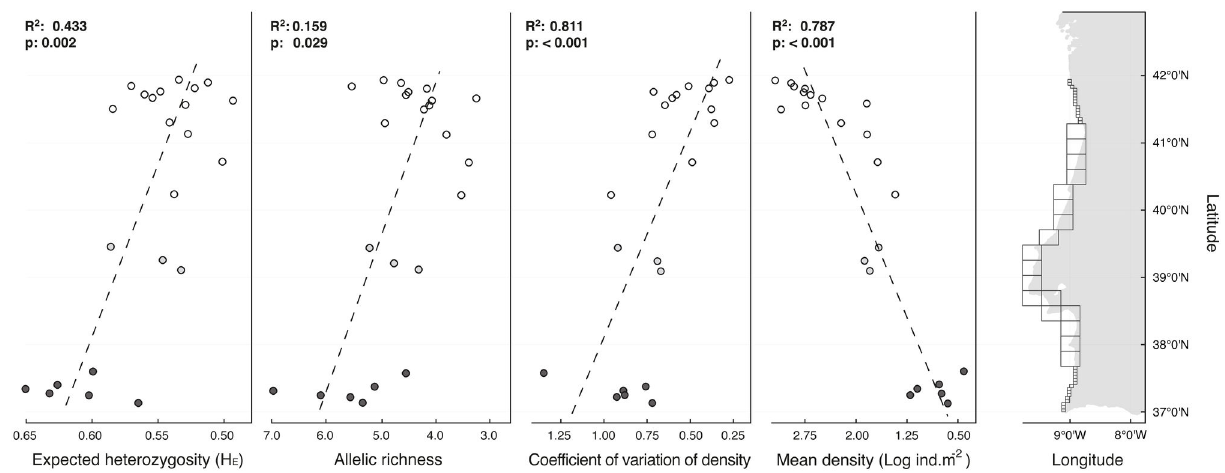
Figure 1. Sampling scheme for S. polyschides (cells represent the sampling units) within 25 km cells along the study range, and for detailed northern-southern comparisons within sub-cells of 5 km. Expected heterozygosity (H coefficient of variation of density and mean density (values increase from right to left; North: white circles, Center: grey circles, South: black circles) plotted against latitude (decimal degrees at WGS84). R-squared and p-values for linear models (dashed lines) fitted for sites with density records and genetic